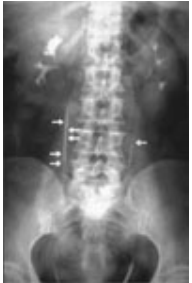
FIGURE 1 . IVP showing the filling defects in the right ureter of first patient.